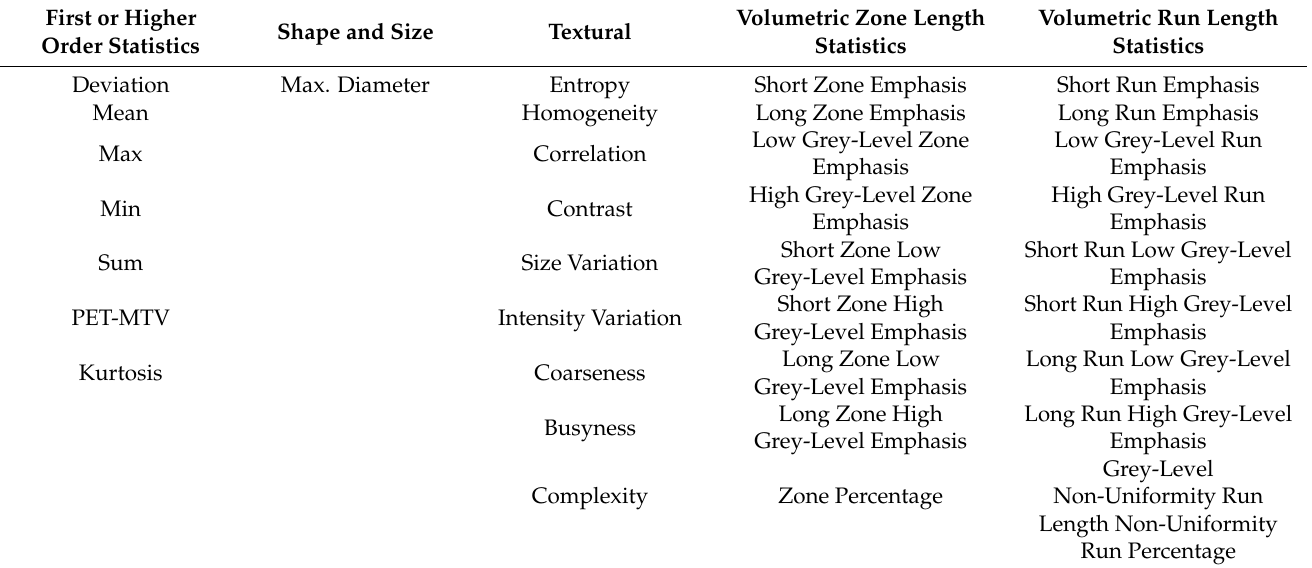
Table 2. A list of the radiomics features from both positron emission tomography (PET) and computed tomography (CT) modalities. Please note that the metabolic tumor volume (MTV) is PET-specific. This table is already published in [20]. First or Higher Order